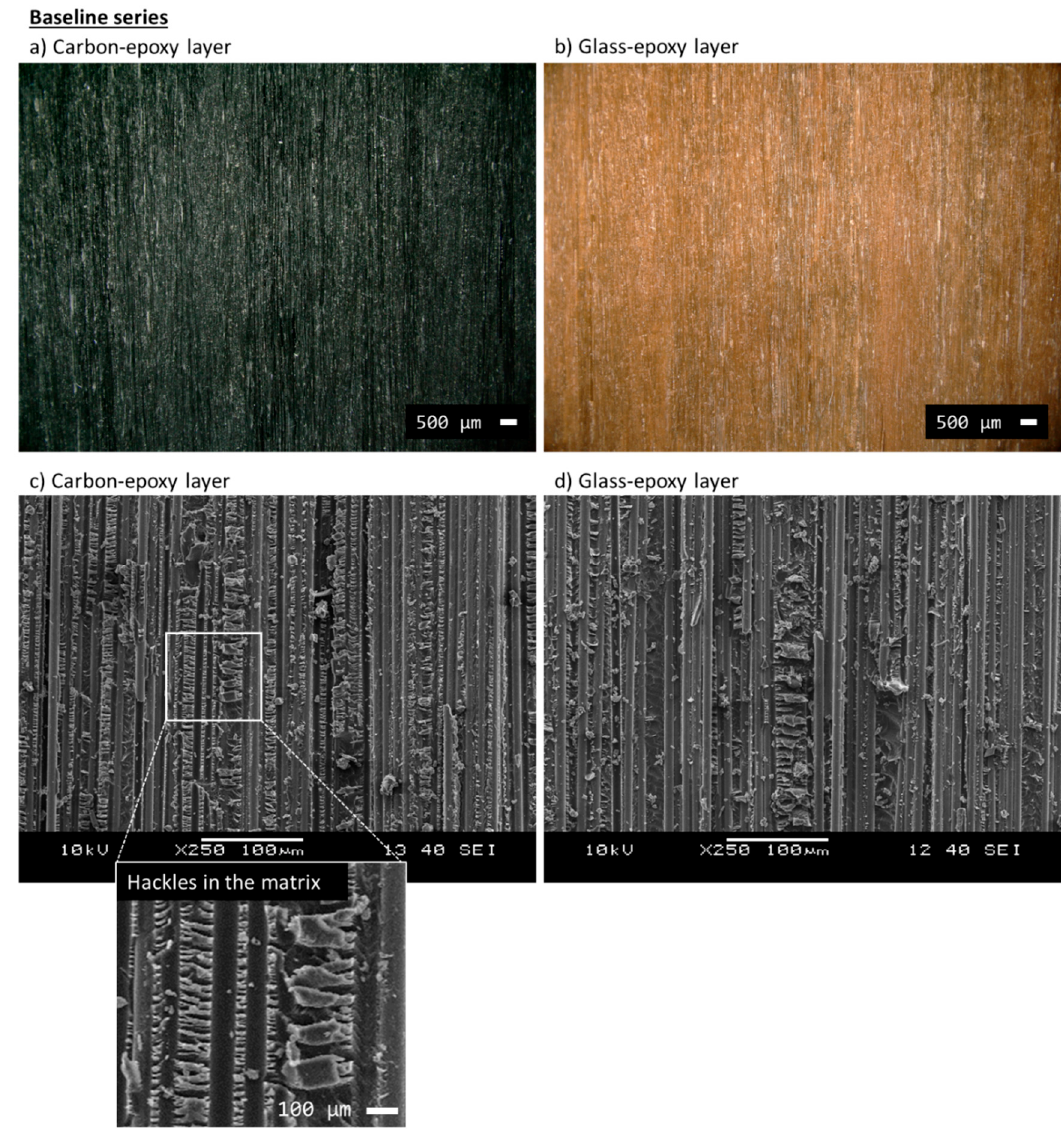
Figure 7. Microscope analysis of the baseline samples [G 2 / C / G 2 ] after delamination: ( a ) carbon / epoxy layers analysed with digital microscope and ( c ) SEM; ( b ) glass / epoxy layers analysed with digital microscope and ( d ) SEM. The inset in ( c ) provides a detailed view of the hackles of the epoxy matrix.